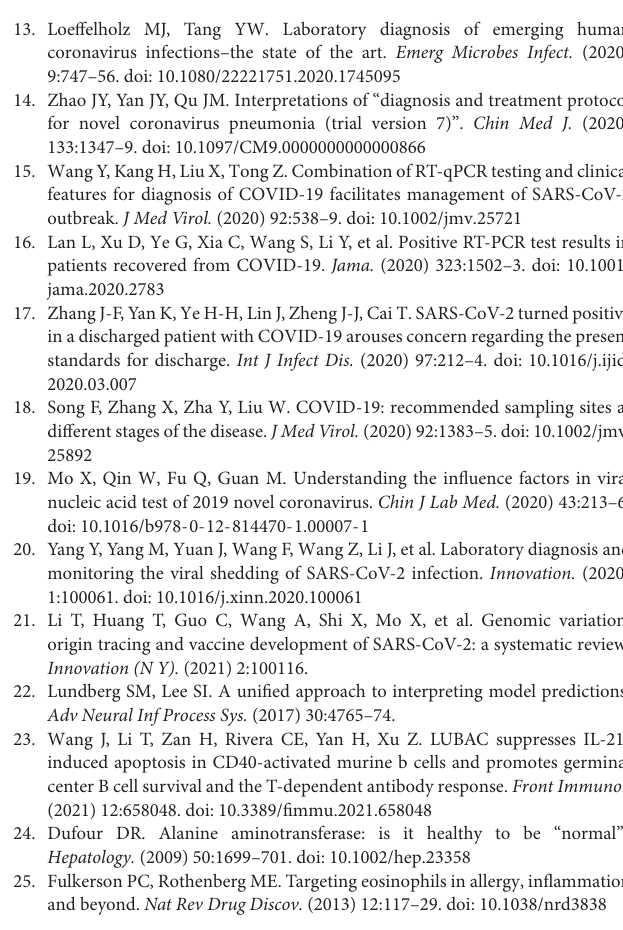
Supplementary Table 4 | The comparison of SARS-CoV-2 detection among different sampling